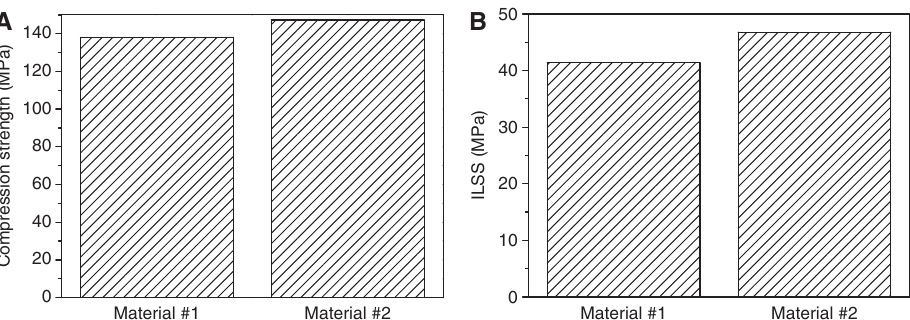
Figure 8: Strain nephogram of spherical shell’s first, third, and sixth layers (torque).